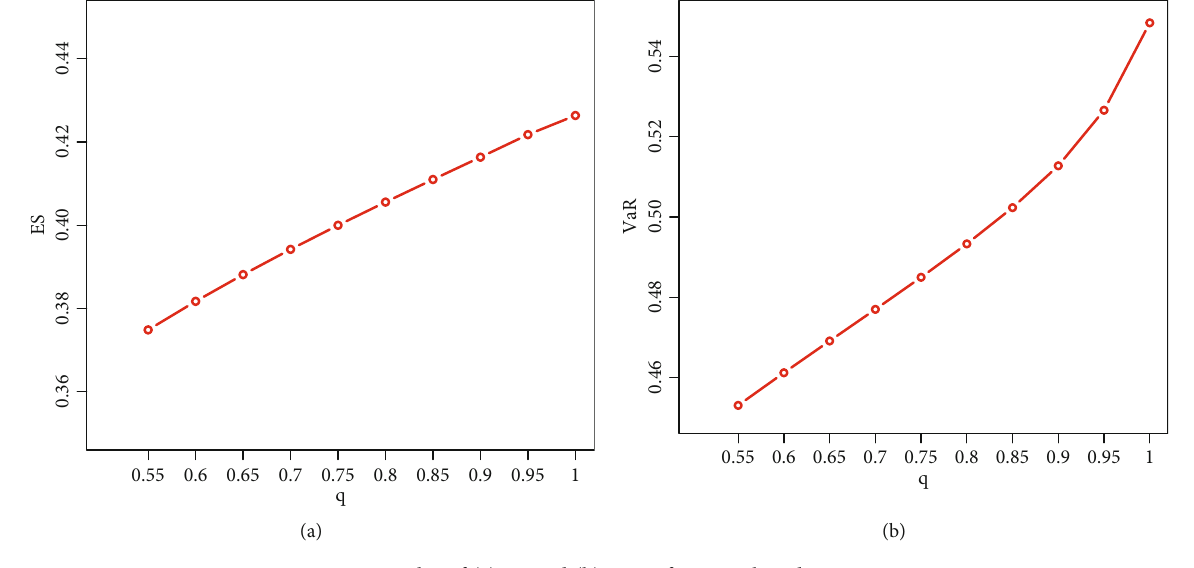
Figure 10: Plot of (a) ES and (b) VaR of UPWD based on MLEs. Table 3: Real data sets along with descriptive